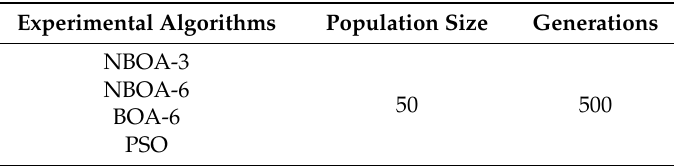
Table 3. Experimental parameter settings.